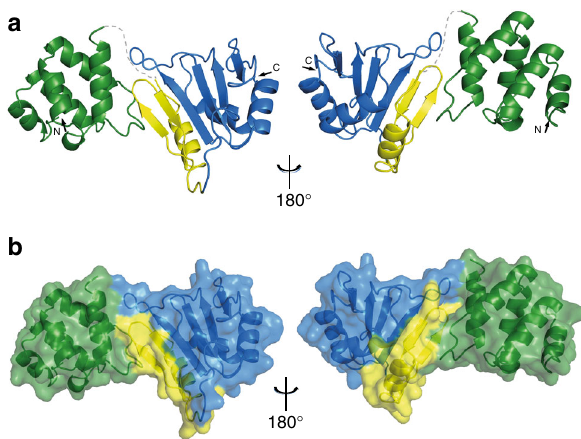
Fig. 2 The N-terminal mRNA-binding region of Syncrip folds as a two- domain structural unit centred on a novel αββ element. a Cartoon representation of the structure of the NeR1 construct (aa 18 – 243). The N- terminal domain is coloured in green, the αββ extension in yellow and the canonical RRM1 in blue. The dashed grey line indicates the fl exible linker between the two domains, which is not visible in the electron density map. b Surface representation of the di-domain. The RRM1 extension bridges the gap between the N-terminal and core RRM